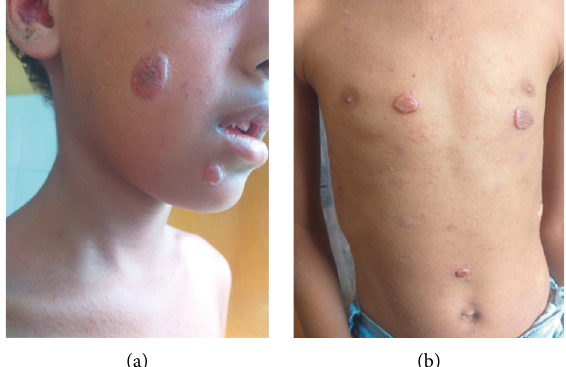
Figure 2: a and b well-demarcated skin-colored indurated plaque lesion with the fine-scale on the right side of cheek, chin, chest, and abdomen.